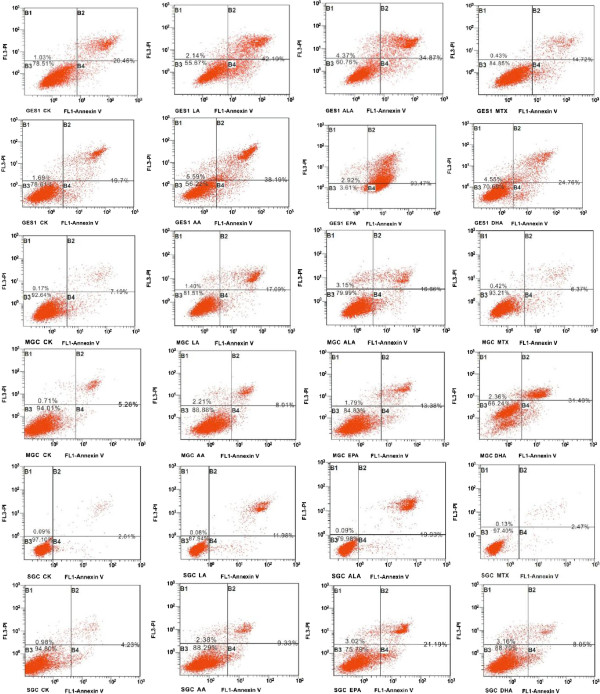
Flow cytometric analysis of GES1, MGC and SGC cells treated with various PUFAs and methotrexate to determine their apoptosis on exposure to various treatments. (150 uM LA and ALA on GES1 cell line, while AA, EPA and DHA were supplemented at 180 uM to GES1、MGC and SGC cell line; duration of incubation: 48 h.